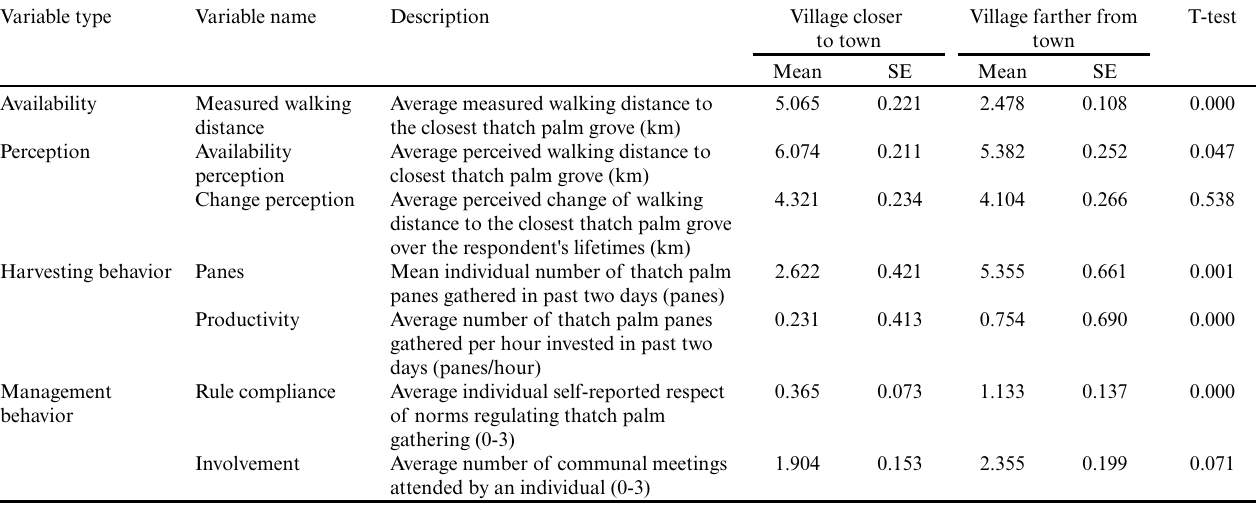
Table 4 . Definition and summary statistics of variables measuring behavior and perceptions in the two villages under